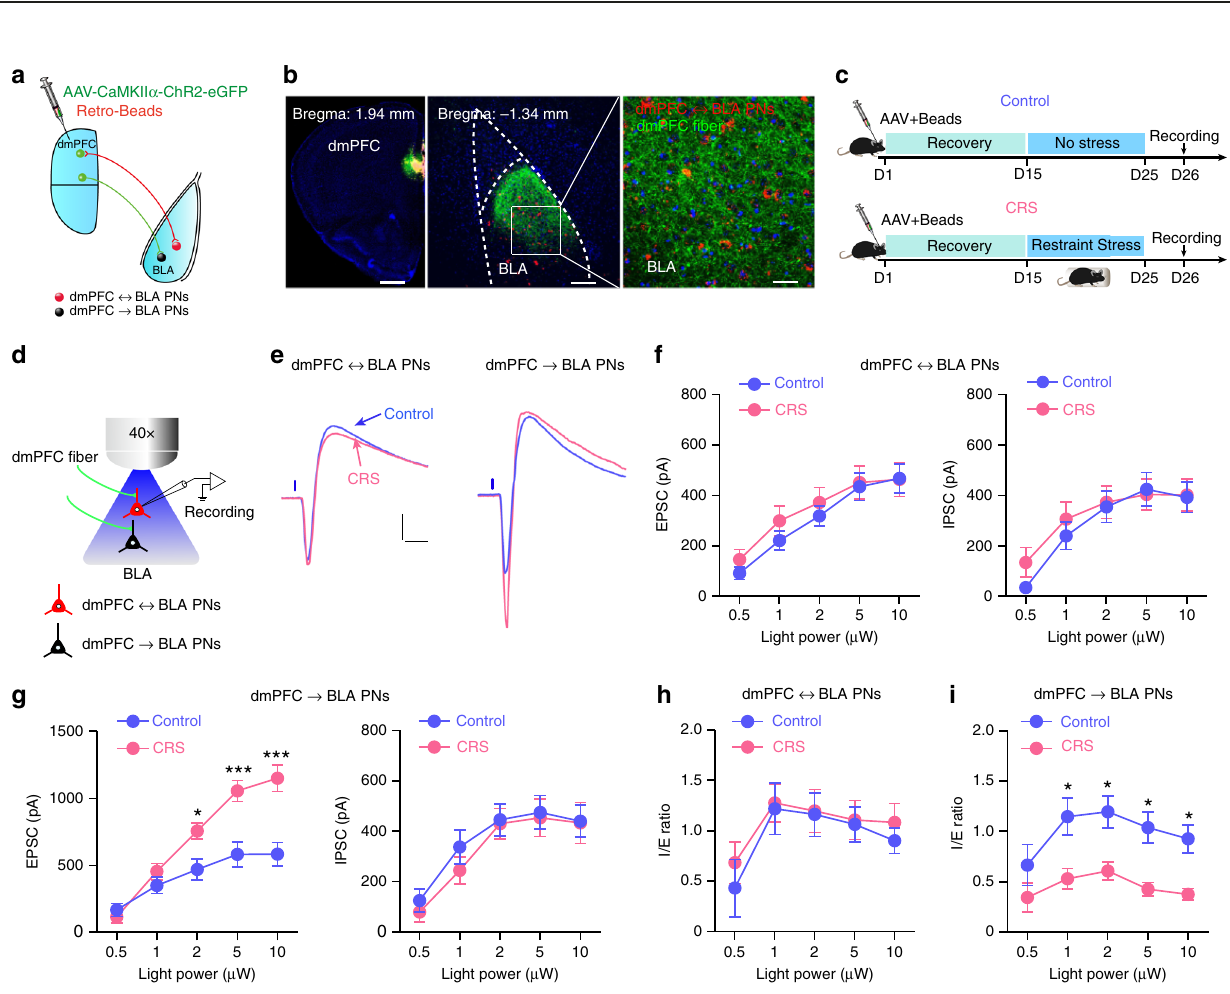
Fig. 2 Chronic stress selectively augments dmPFC-evoked glutamatergic transmission onto dmPFC → BLA PNs. a Schematic showing co-injection of ChR2-carrying AAV vectors and red fl uorescent Retrobeads into dmPFC. Retrobeads were used to differentiate the putative dmPFC → BLA and dmPFC ↔ BLA PNs in BLA. b Representative images showing the injection site in dmPFC (left) and red Retrobeads-labeled dmPFC ↔ BLA PNs and dmPFC inputs in BLA (middle). The expanded square was shown on right. Scale bar: 500, 100, and 20 μ m (left to right). c Schematic showing the experimental procedures for control mice and mice subject to chronic restraint stress (CRS). d Schematic showing recording of the postsynaptic responses in dmPFC → BLA or dmPFC ↔ BLA PNs to optogenetic activation of dmPFC inputs. e Representative traces showing the biphasic EPSCs/IPSCs in dmPFC ↔ BLA and dmPFC → BLA PNs following optogenetic activation of dmPFC inputs. Cells were held at − 30 mV. Scale bar = 10 ms, 200 pA. f Summary plots of the EPSCs (left) and IPSCs (right) in dmPFC ↔ BLA PNs with increasing light intensity. Control, n = 14 neurons/4 mice; CRS, n = 15 neurons/4 mice. g Same as in f except that the data were from dmPFC → BLA PNs. Control, n = 15 neurons/5 mice; CRS, n = 13 neurons/4 mice. h Summary plots of the I/E ratio in dmPFC ↔ BLA PNs. Same sample size as in f . i Same as in h except that the data were from dmPFC → BLA PNs. Same sample size as in g . Data are presented as mean ± SEM. Statistics are shown in Supplementary Table 1. * p < 0.05, *** p < 0.001. Source data are provided as a Source Data fi